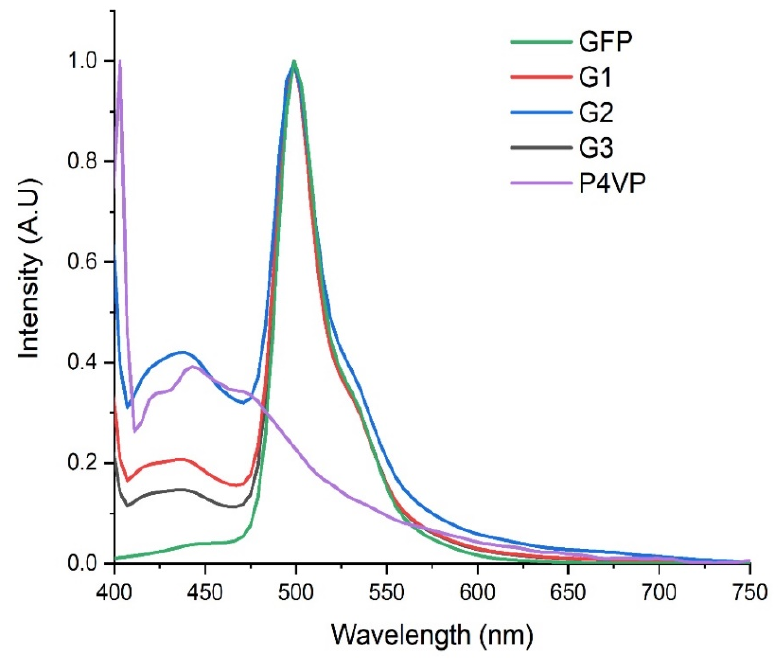
Figure 5. Fluorescence spectra of GFP, P4VP, and CSNPs with various sizes.